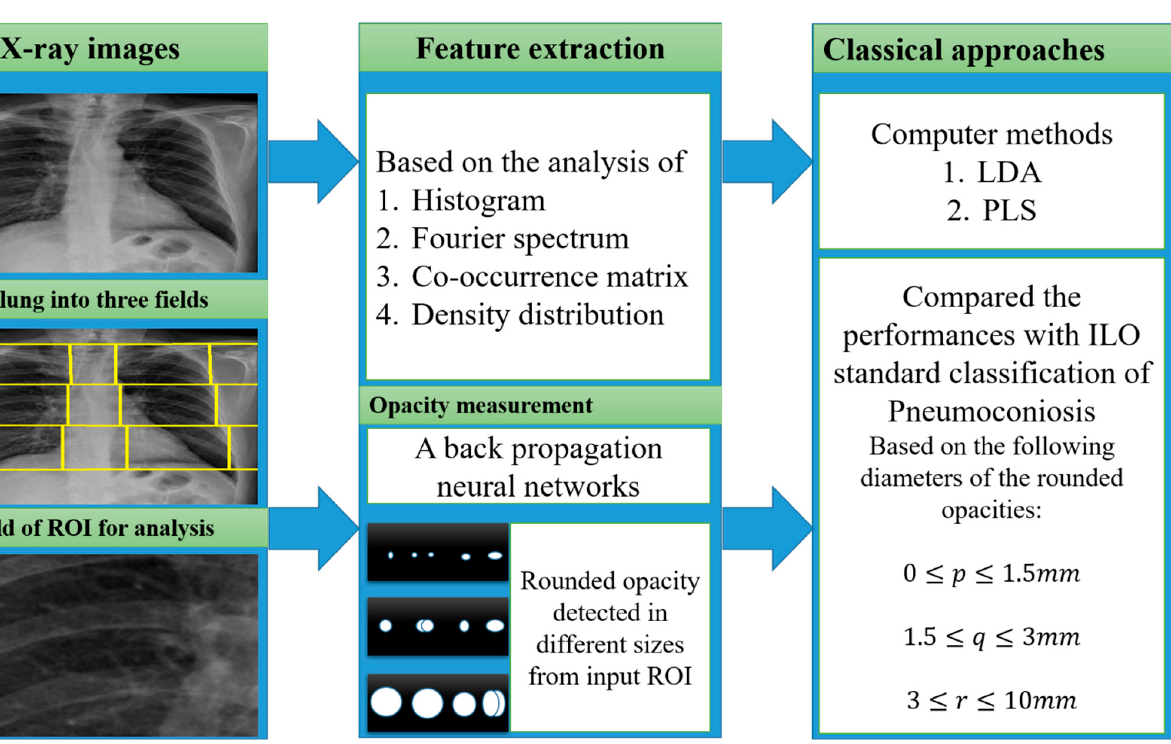
Figure 4. The illustration of the classical approaches was used for CWP